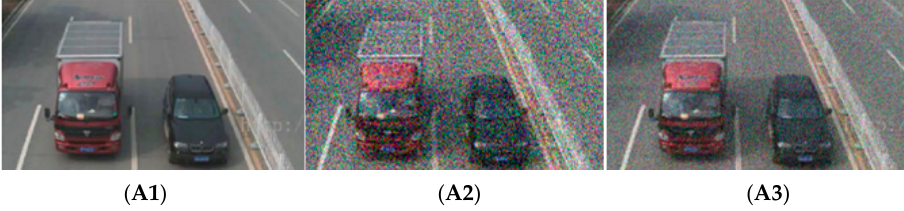
Figure 13. Vehicle images: model performance trained with 64 × 64 image size. ( A1 ) The original image; ( A2 ) the noisy image; ( A3 ) denoised image with σ = 25 .